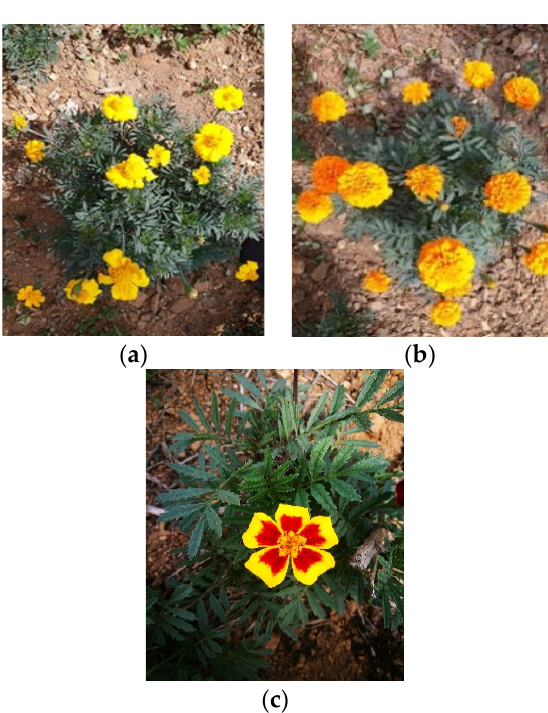
Figure A1. ( a ) Janie Yellow Bright, ( b ) Jinmen Orange, ( c ) Shouyao Red and Yellow color.